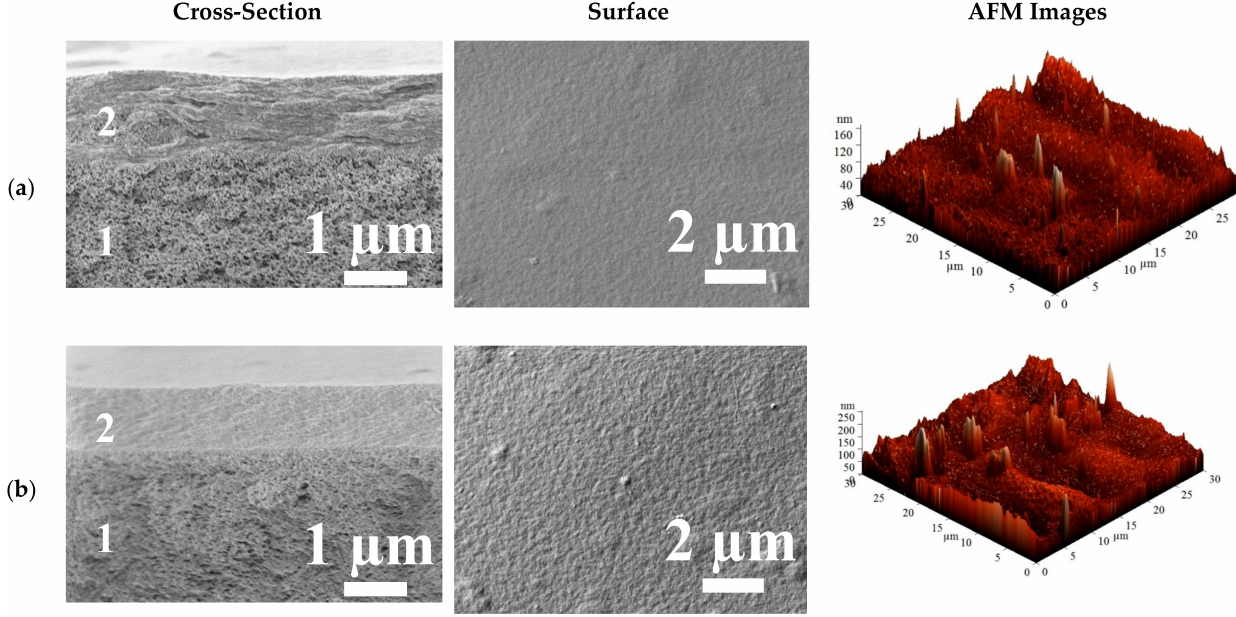
Figure 13. The cross-sectional and surface SEM micrographs, AFM images of the cross-linked ( a ) HEC/SA/PAN CaCl2 and ( b ) HEC/SA-5/PAN CaCl2